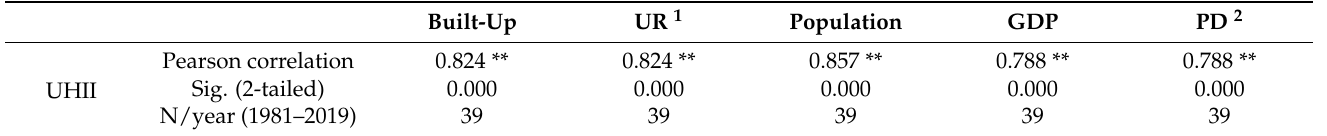
Table 1. Analysis of the relationship between urban development indicators and UHII.